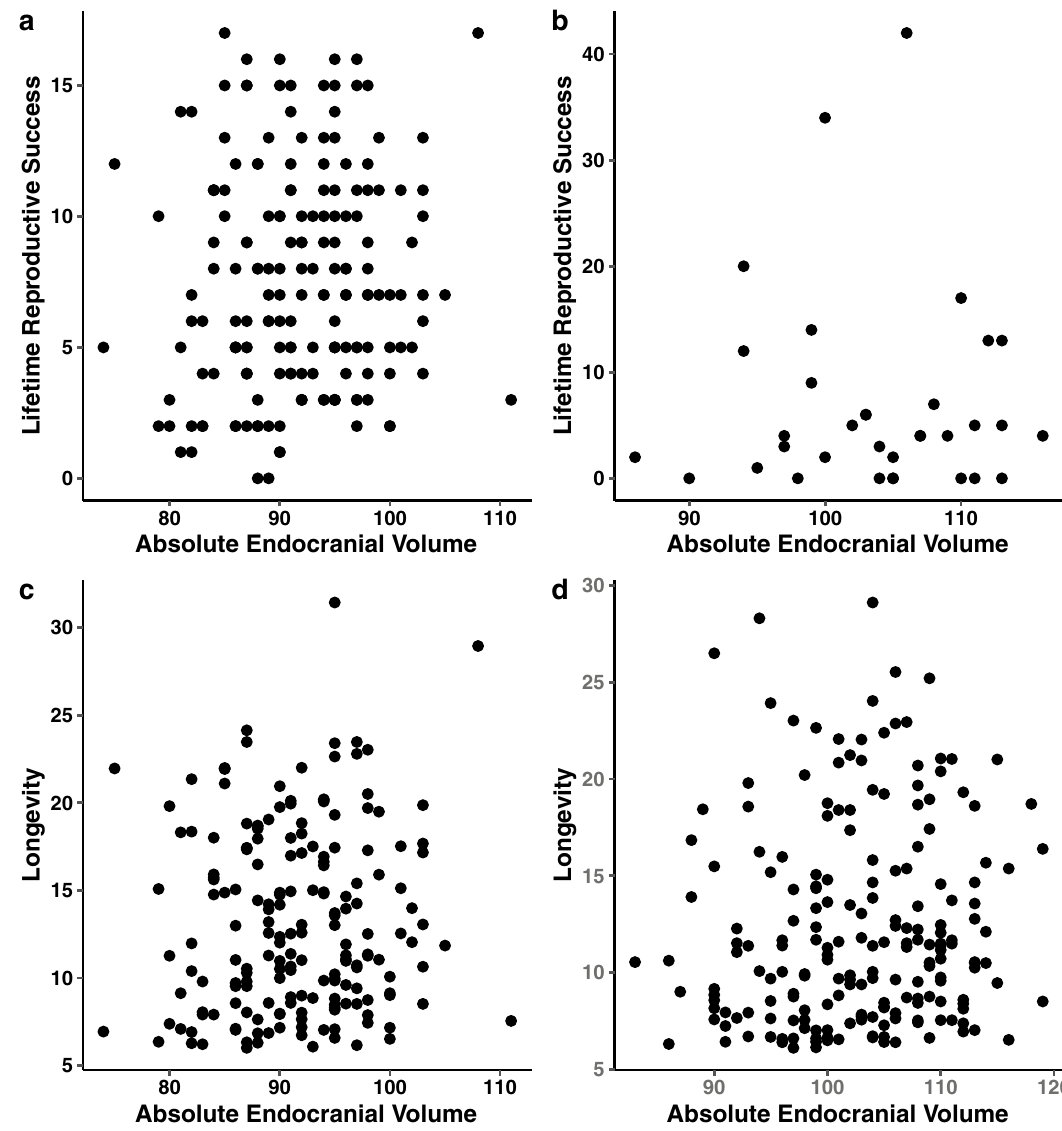
Figure 2. Absolute endocranial volume against: ( a ) lifetime reproductive success (females) (n = 177); ( b ), lifetime reproductive success (males) (n = 34); ( c ) longevity (females) (n = 186); ( d ) longevity (males) (n = 198). Lifetime reproductive success is the number of offspring to survive to one year. Longevity is measured as age at